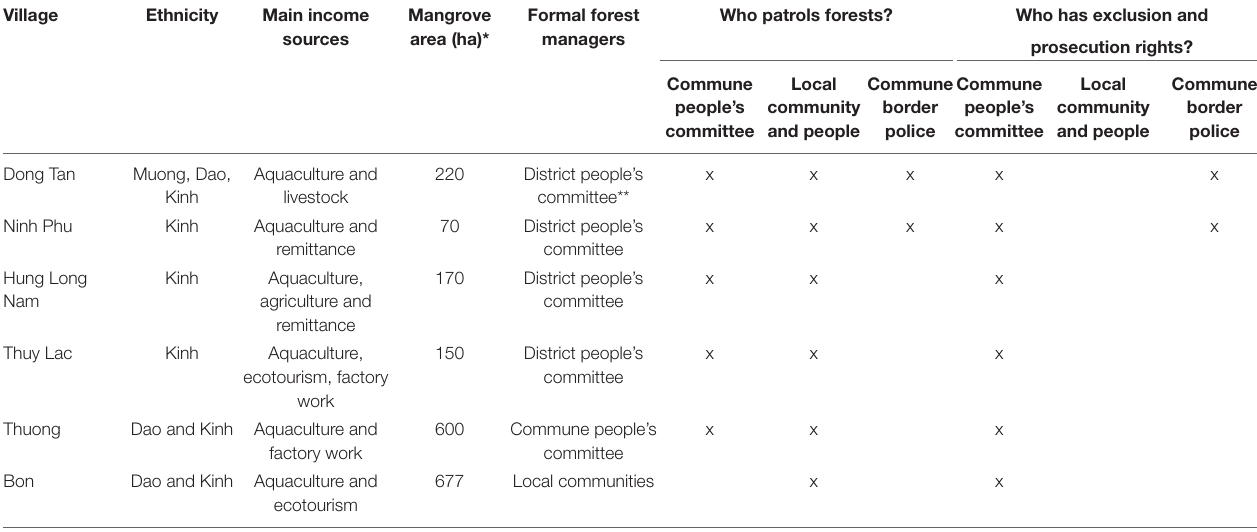
TABLE 1 | Background information about the study villages.